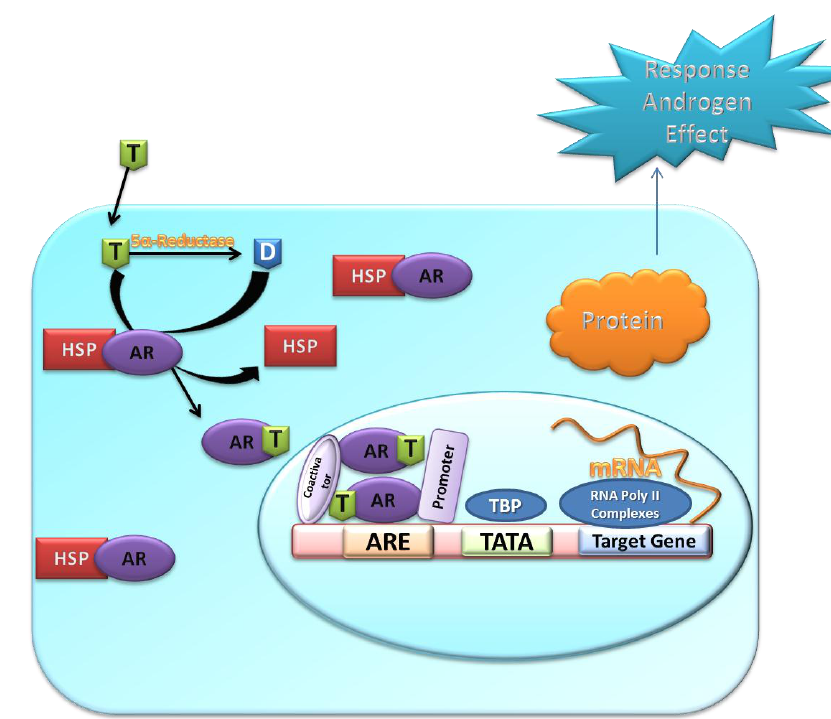
Figure 2. Illustration of AR signaling path. T, Testosterone; D, dihydrotestosterone; HSP, heat shock proteins; AR, androgen receptor; ARE, androgen response elements. When T enters the cell, it either is converted into the more potent D by 5α-reductase and binds to the ligand binding pocket of AR. AR–agonist complex is then translocated into the nucleus with help of other proteins to form AR-dimer that binds to ARE of DNA and co-regulator proteins to initiate transcription of AR.